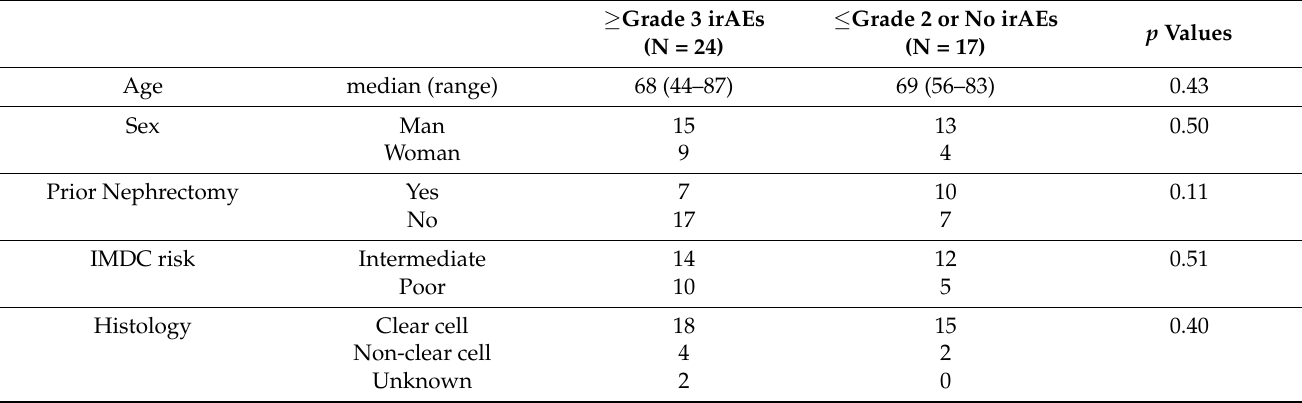
Table 3. Assessment of predisposing factors for high grade